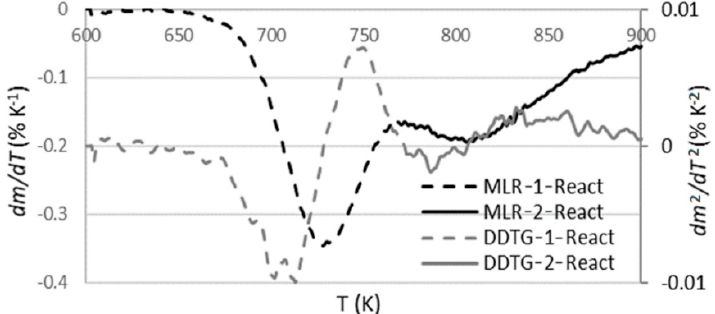
Figure 3. Second derivative method to define the decomposition reactions applied to NOMEX. dm / dT black line and dm 2 / dT 2 grey line.